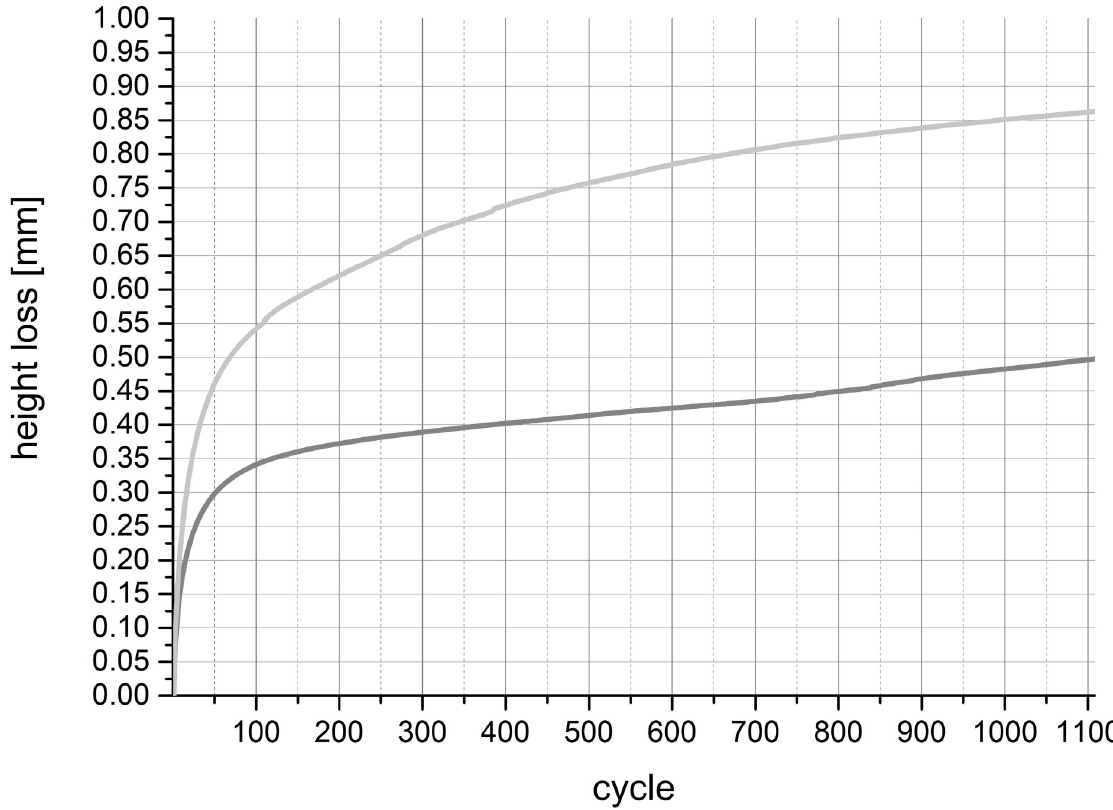
Fig 6. HL of the cartilage specimens during a 2.05 h tribological test with 1108 cycles. The averaged values of all specimens of the old group are depicted in dark grey, and those of the young group in light grey. The final value of the HL after tribological exposure was 0.52 mm for the old and 0.86 mm for the young group. The difference was significant (p < 0.0001). Standard deviations are reported in Table